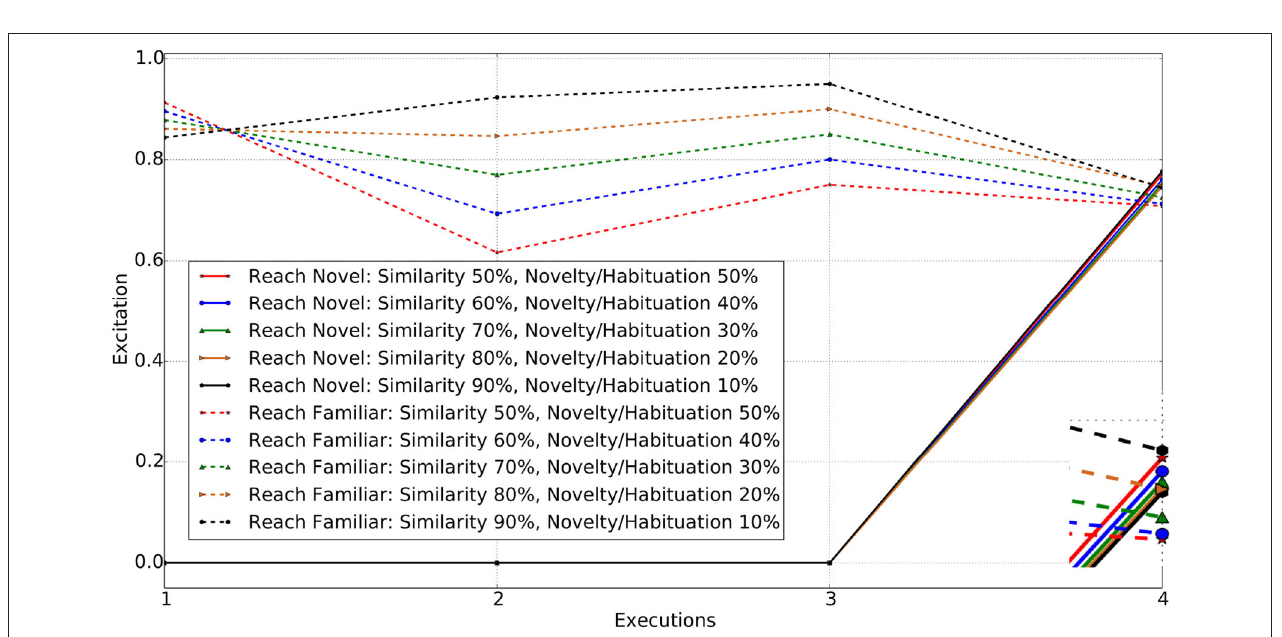
In particular, this figure shows the most excited schema, hence the action, for each execution at different paired values of ω 3 and ω 4 , for 10 executions. From the results, it is evident that the agent shows different behaviors as the weights vary. As the weight shifts toward ω 4 , the agent becomes increasingly inclined to frequently switching between actions, rather than to explore the effects of the previous action